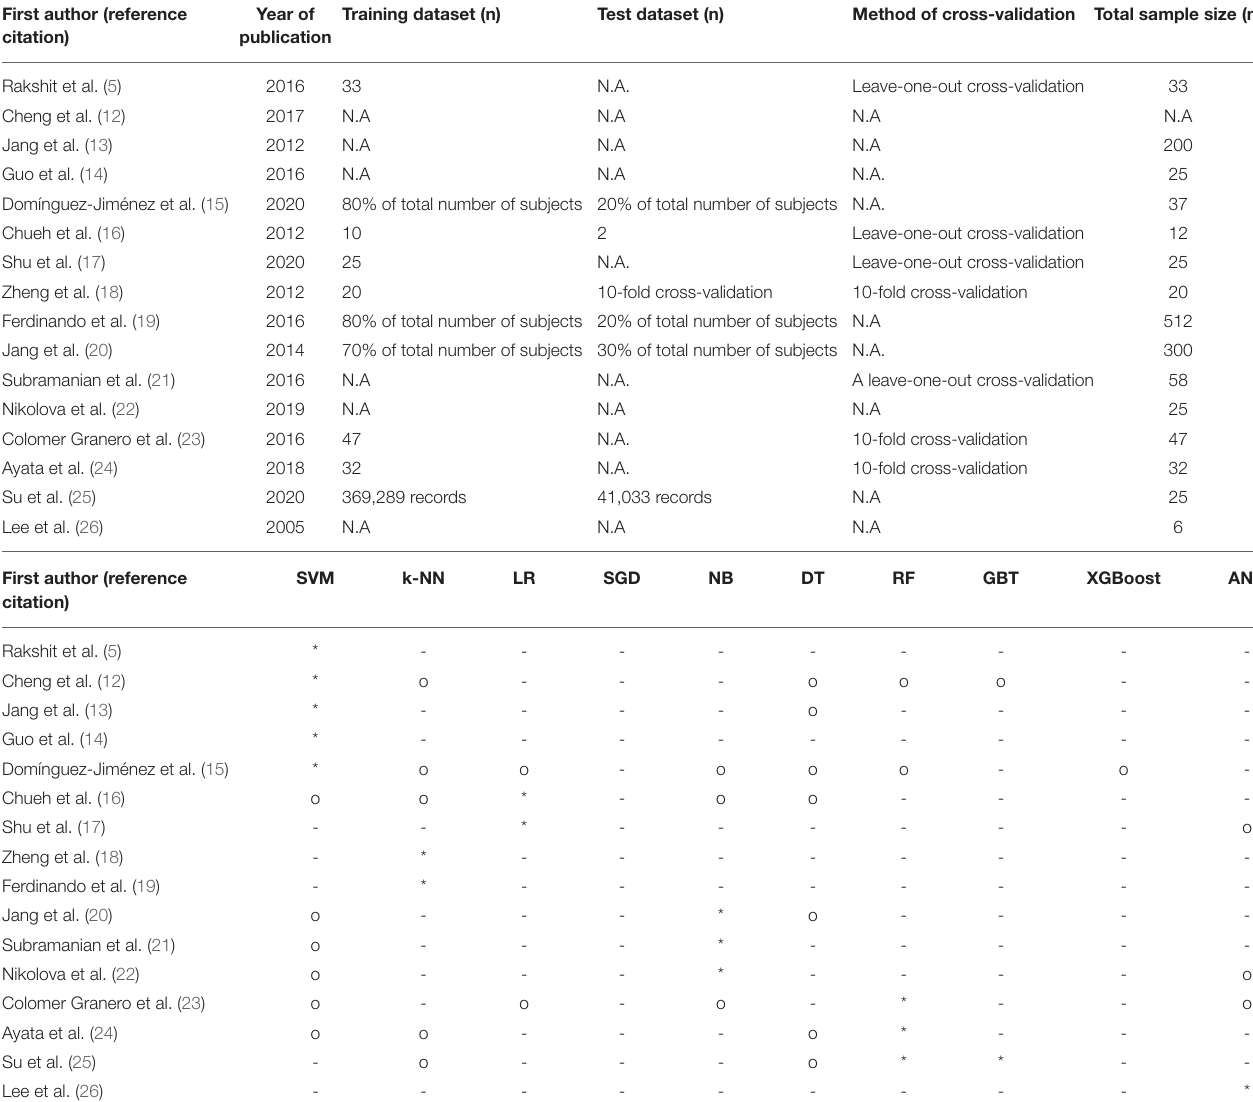
TABLE 3 | Previous machine learning studies to predict emotions based on heart rate